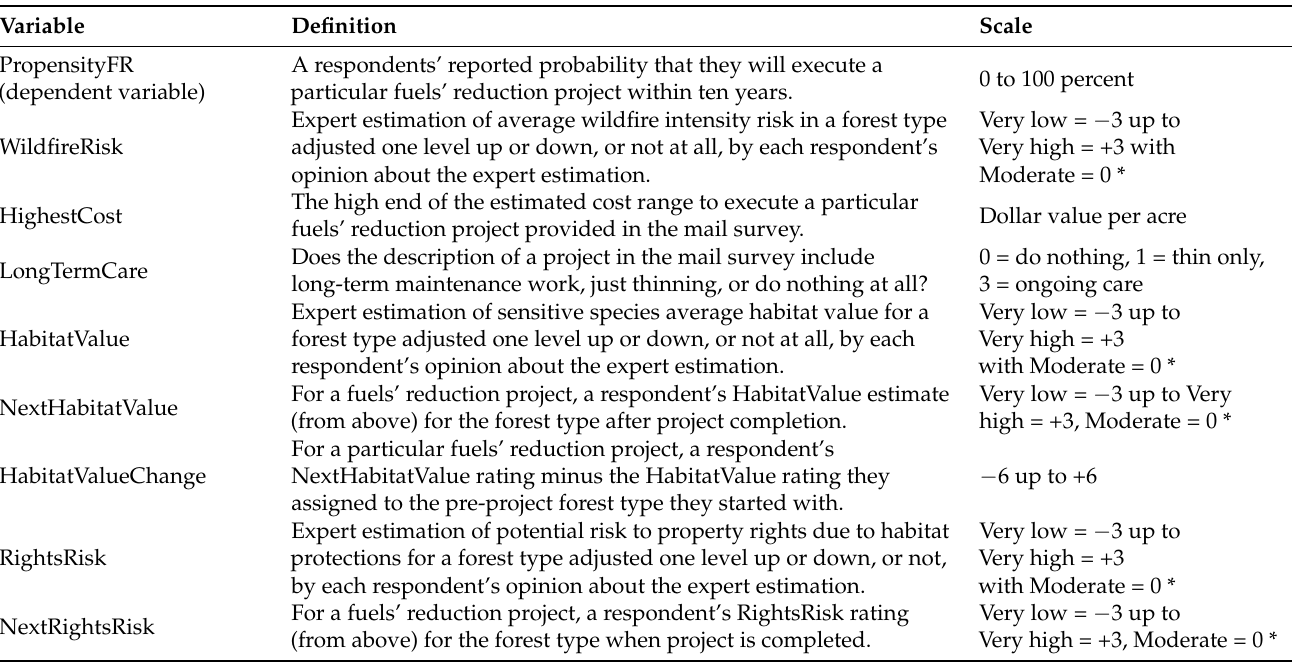
Table 2. Variables used in modeling fuels reduction